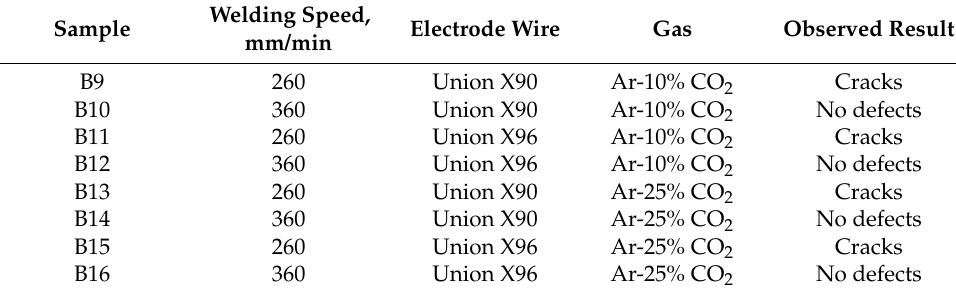
Table 7. NDT test results for connectors made of DOCOL steel 1300